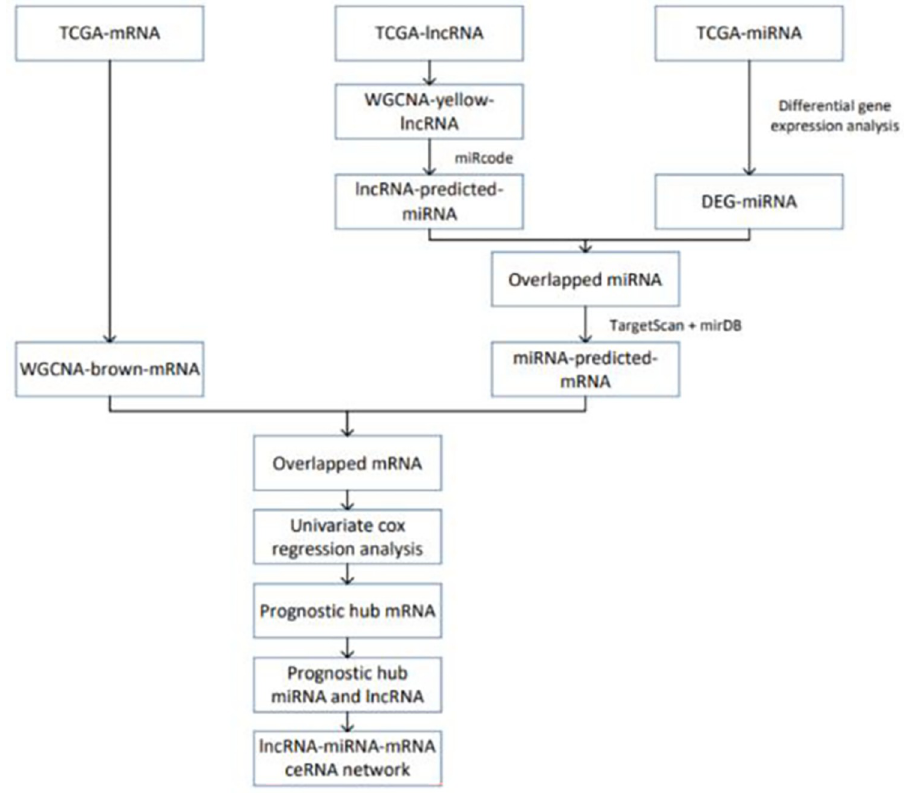
Fig 11. The analysis flow of the